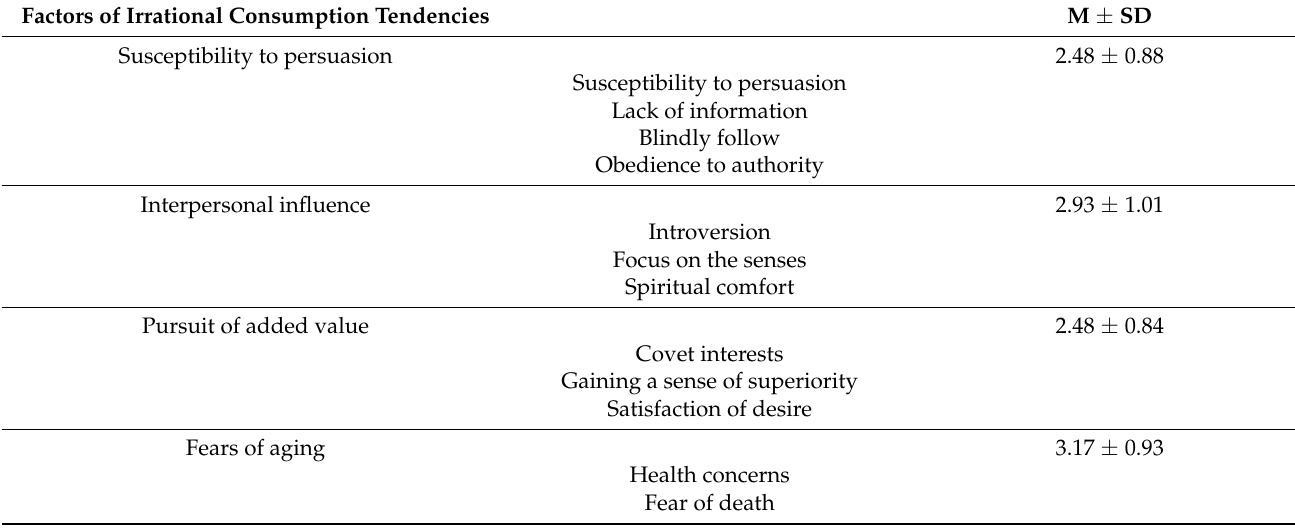
Table 4. Scores of influencing factors for irrational consumption